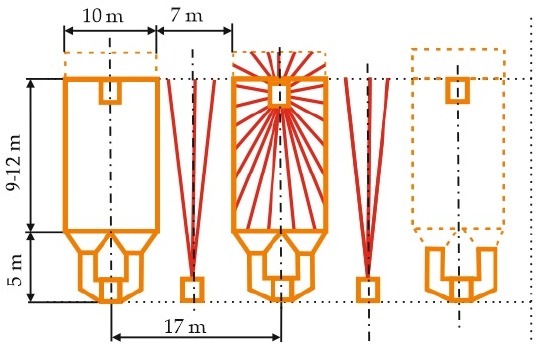
Figure 13. Room and pillar mining method with bottom discharge. Blasting holes in red.